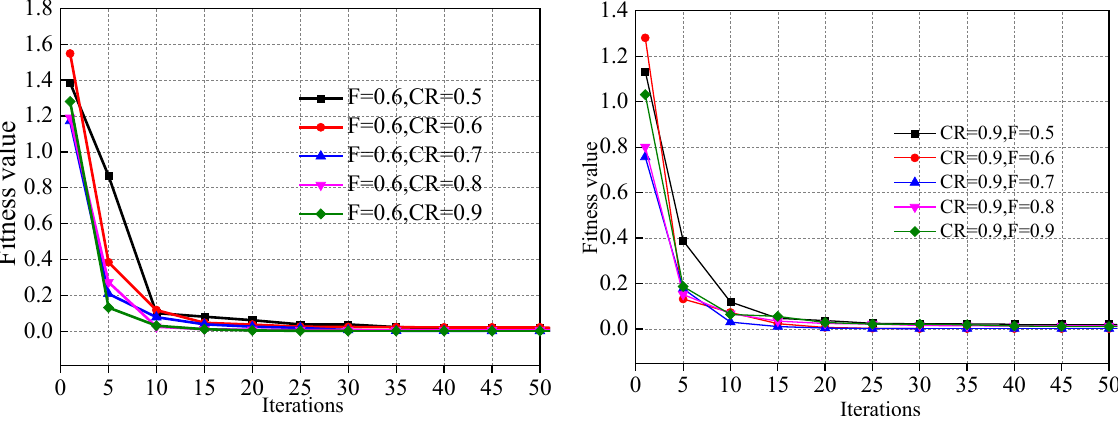
Figure 10. Iteration curve.